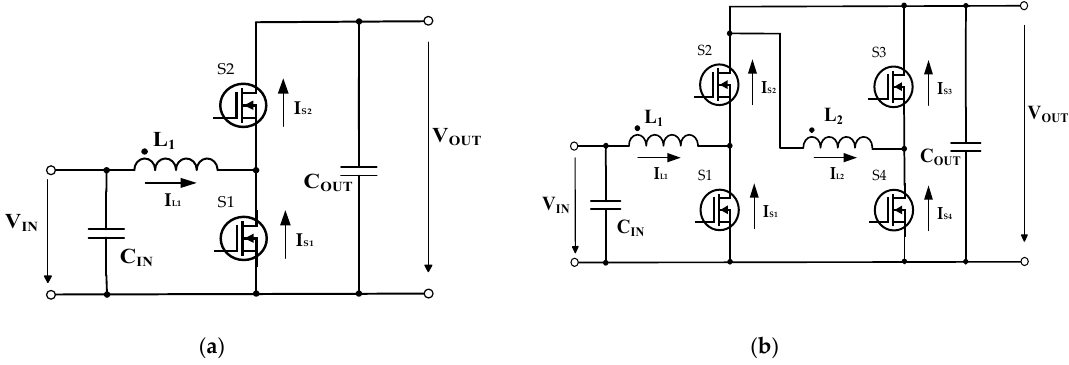
Figure 3. Circuit schematic of non-modular interleaved bi-BB converter ( a ) and circuit schematic of one module for the modular solution of bi-BB converter ( b ).